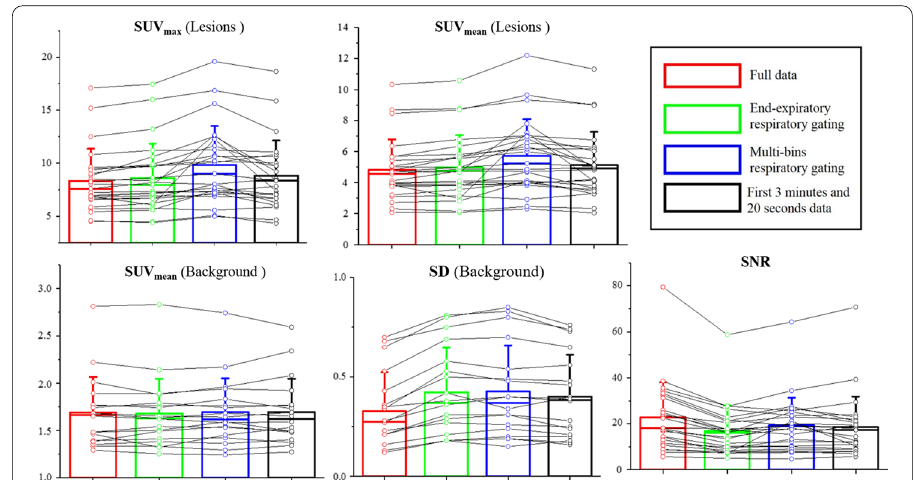
Fig. 2 Means and standard deviations of the five parameters in the four groups. Different colours represent different groups, as shown in the top right corner. The detailed data are also shown by dots and the connected lines for visual paired comparisons